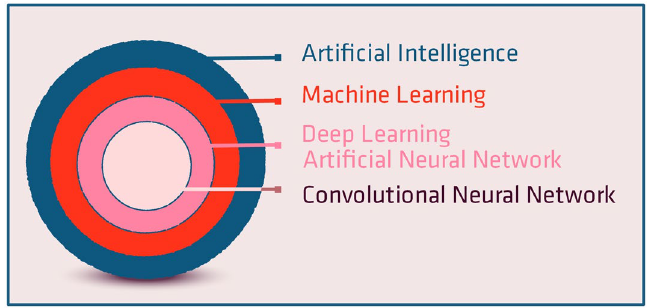
Figure 1. Artificial intelligence (AI) is an umbrella of terms encompassing machine learning and deep learning.